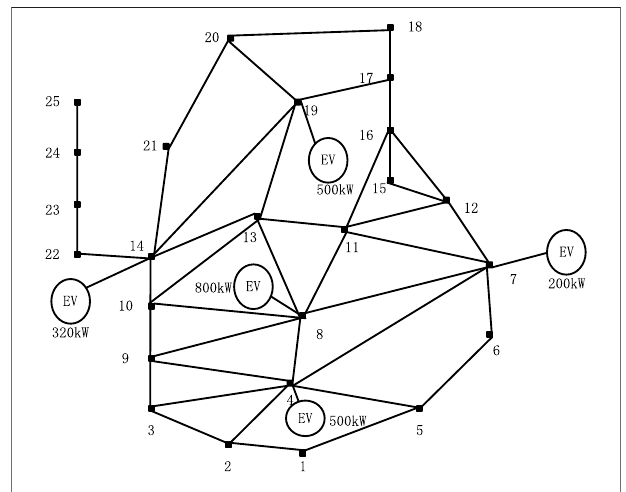
FIGURE 6 | Charging network planning scheme (based on the interpretative structural